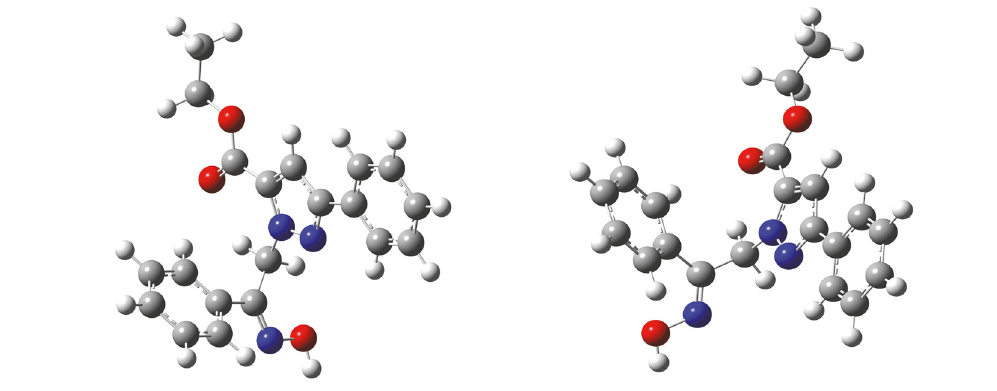
Figure 3: The plots of Z and E configurations of title compound.